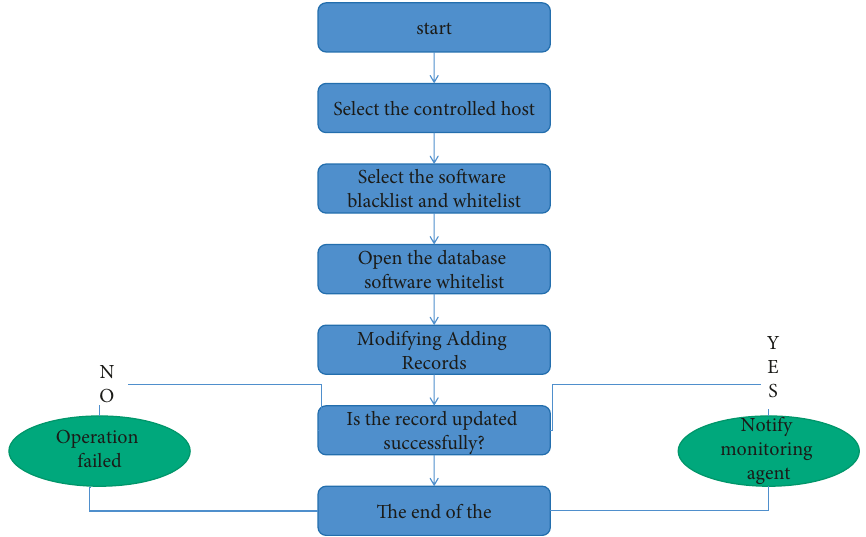
Figure 3: Software black-and-white list policy-setting